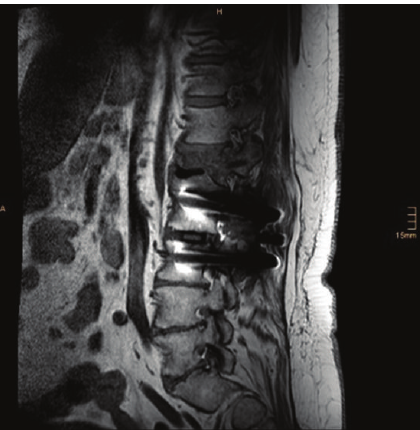
Figure 5: Postoperative sagittal MRI (T1-weighted) at the level of the pedicles